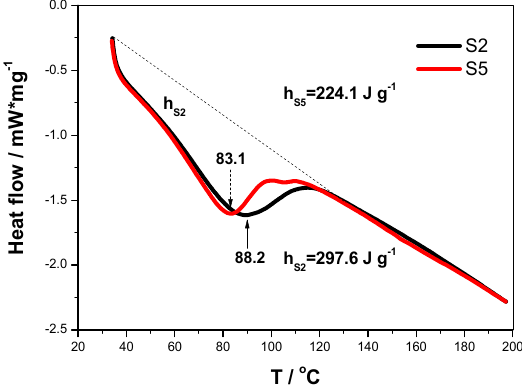
Figure 6. Heat flow of samples including S2 and S5.